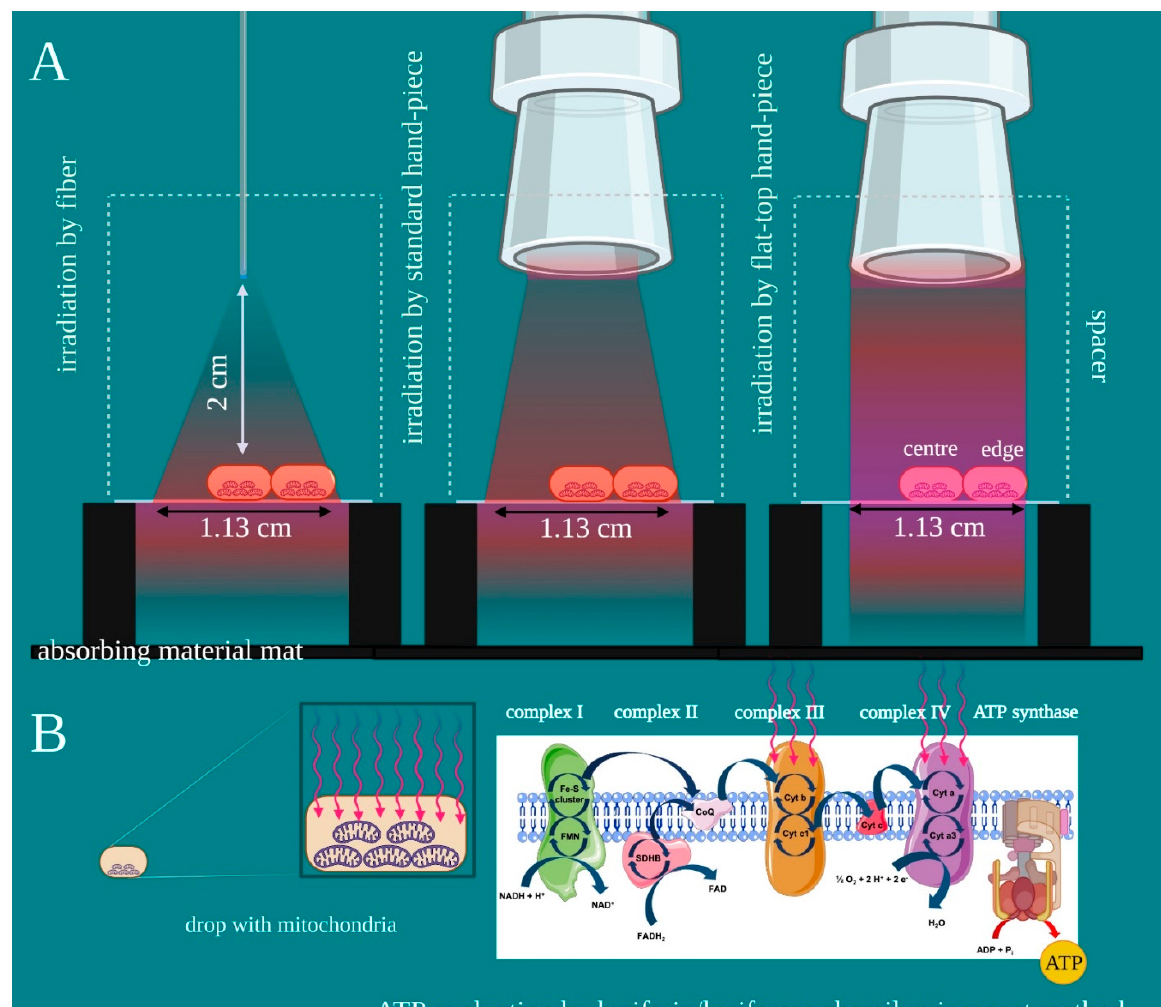
Figure 1. Experimental design. ( A ) A drop of isolated mitochondria enriched-fraction was pipetted on a coverslip, in the centre or the edge of the laser beam circular area, according to the experimental purpose. The drop was then irradiated with an 808-nm laser light (diameter 1.13 cm; spot-size 1 cm 2 ) through a fibre, a standard hand-piece, or the flat-top hand-piece. ( B ) Primary and secondary endpoints were evaluated as ATP synthesis through the luciferin/luciferase chemiluminescent method. Image created with BioRender.com.